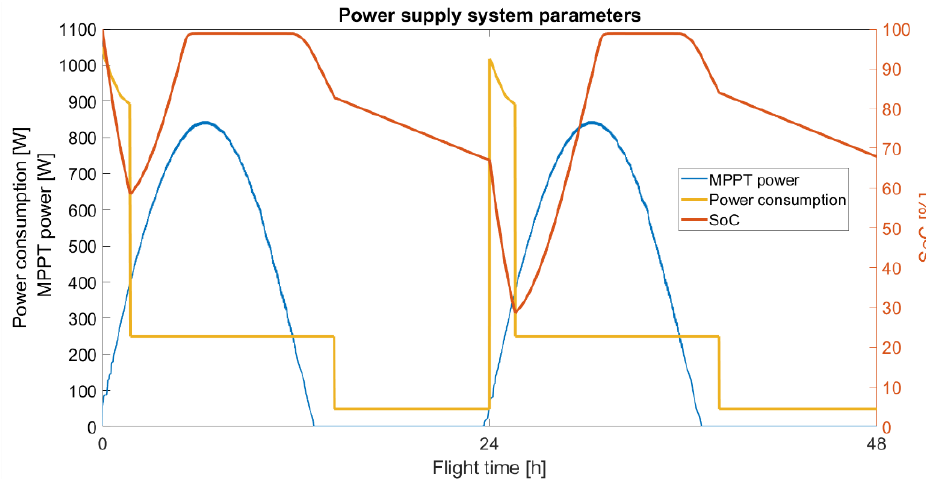
Figure 27. TwinStratos 12 10 km scenario in the vernal equinox.